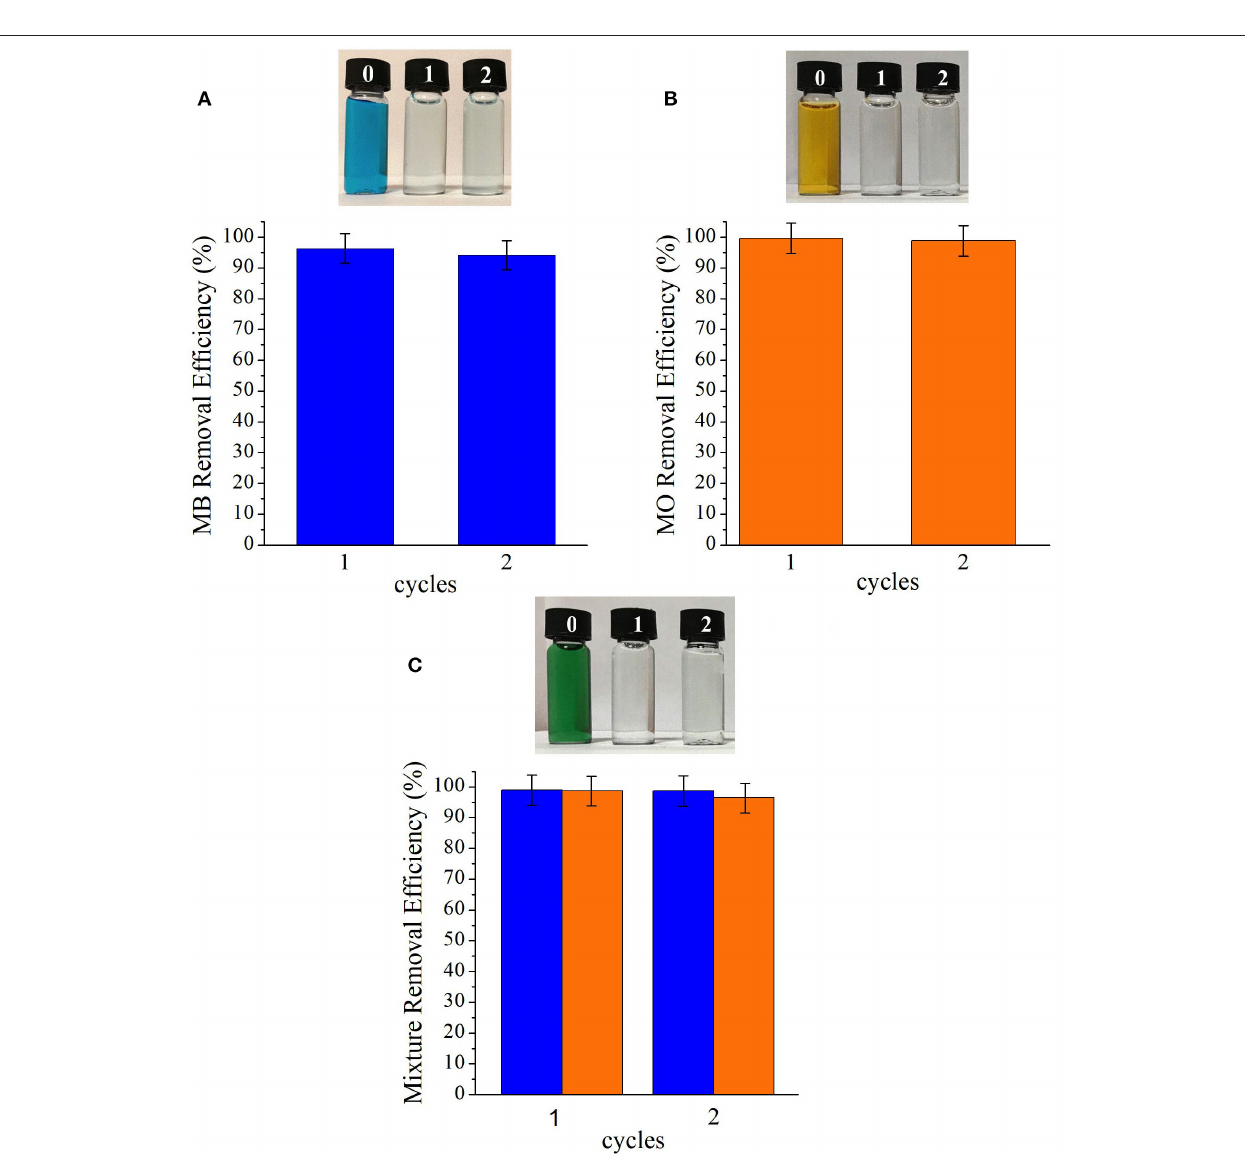
FIGURE 6 | Removal efficiencies of (A) MB, (B) MO, and (C) mixture of MB and MO cycles of [BMIM][PF 6 ]/MIL-53(Al). MB, methylene blue; MO, methyl